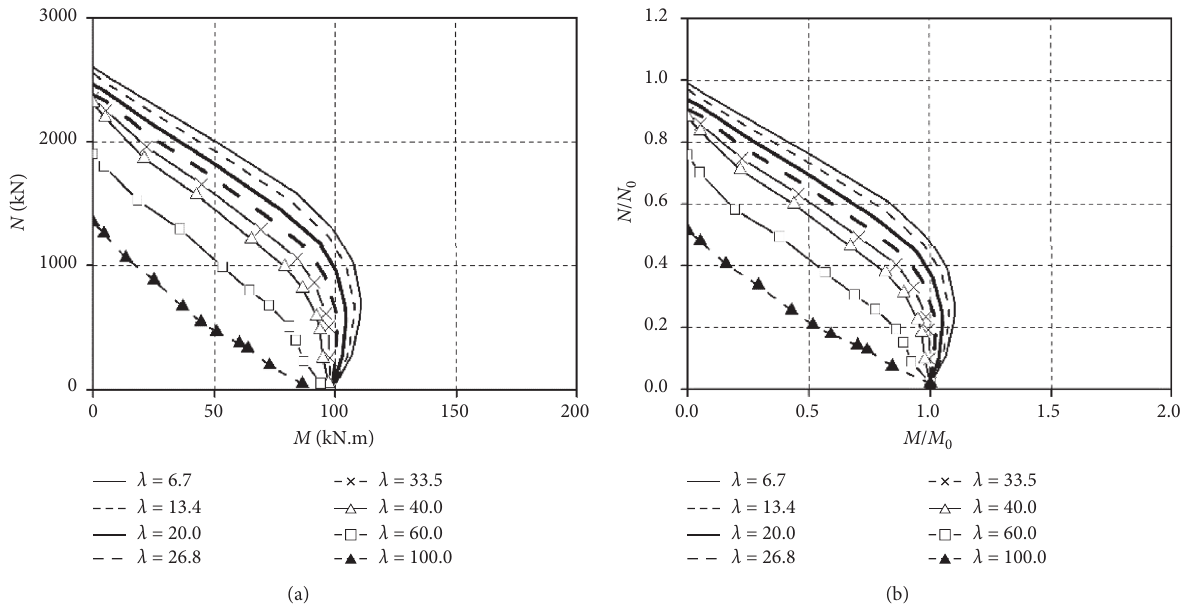
Figure 16: Influence of slenderness ratio λ on the component-based resistance correlation curves. (a) Forward loading. (b) Forward loading